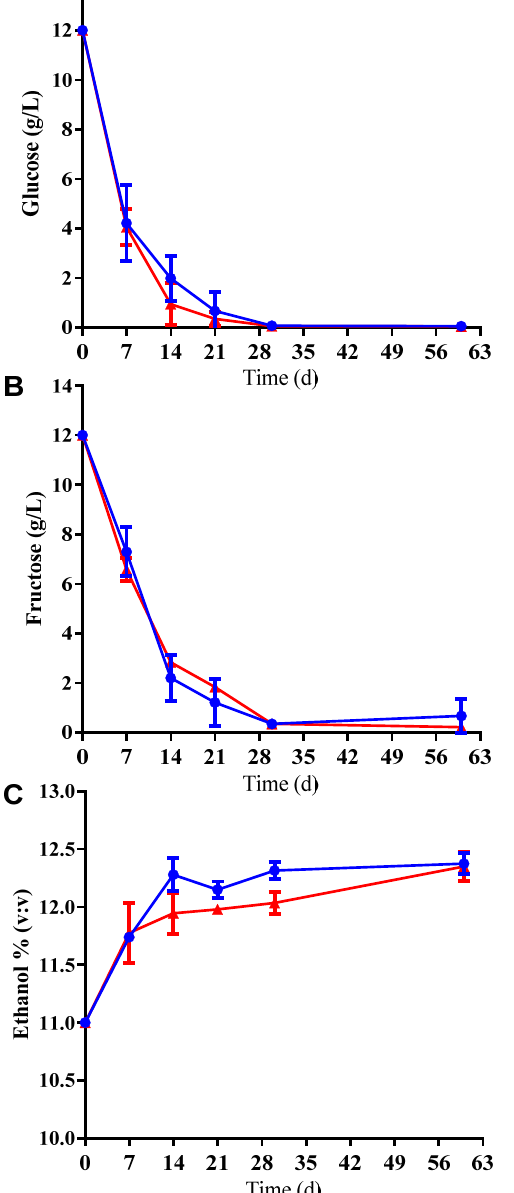
Figure 1. Glucose ( A ) and fructose ( B ) consumption and ethanol ( C ) production kinetics on the first 60 days of the second base wine fermentation performed by S. cerevisiae IOC 18–2007 GPY-grown ( ● ) or pied de cuve -prepared, following the manufacturer’s instructions ( ▲ ). Compounds concentra- tions were determined by HPLC.